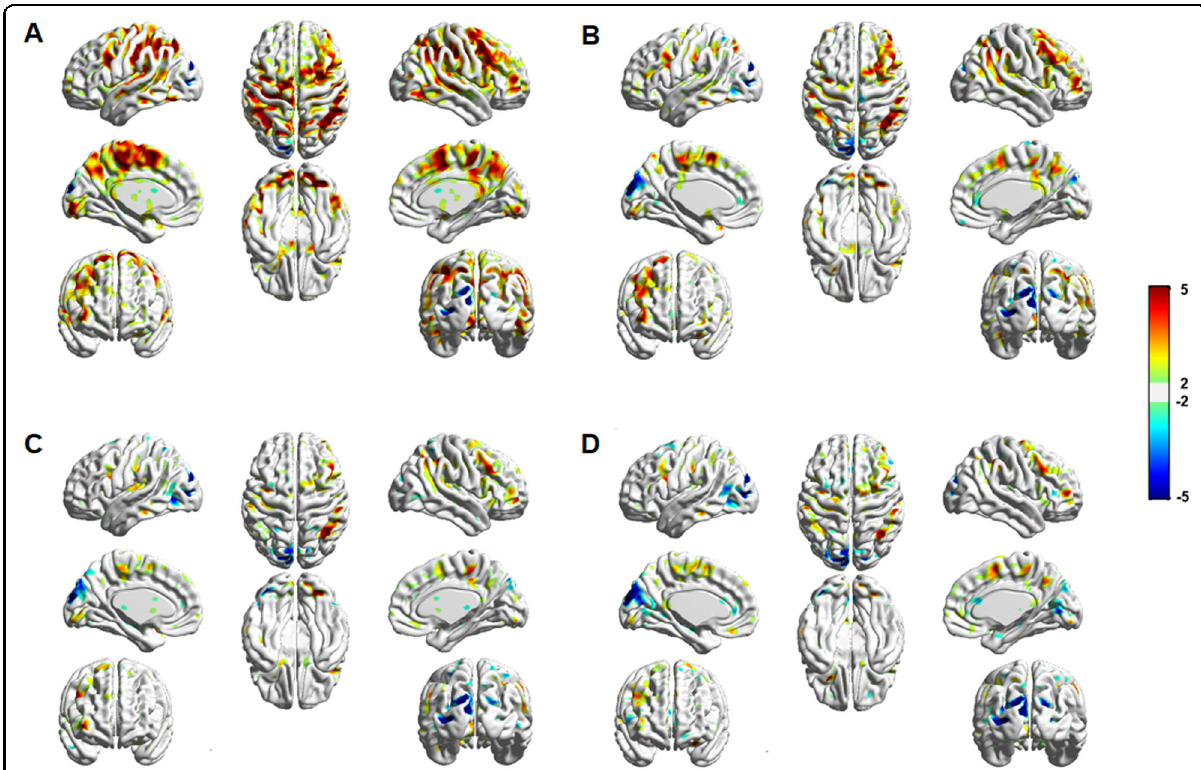
Fig. 2 Brain activation differences between the PSU group and the CON group in each condition during the modi fi ed cognitive con fl ict task. A None, B 1D, C 2D, and D BD conditions. Red represents the brain areas that showed greater activation in the PSU group than in the CON group. The right side of the image corresponds to the right hemisphere of the